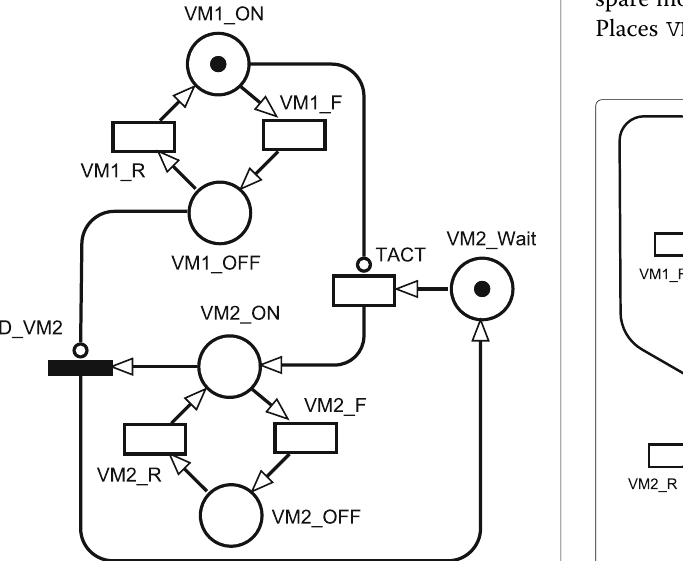
module when the main module is recovered. This redun- dancy mechanism fails if both modules fail. Thus, the operating mode can be expressed as Cold Operational = ( VM1_ON=1 OR VM2_ON=1 ) (8) where a token in the places VM1_ON or VM2_ON , defines the operational state of the environment.